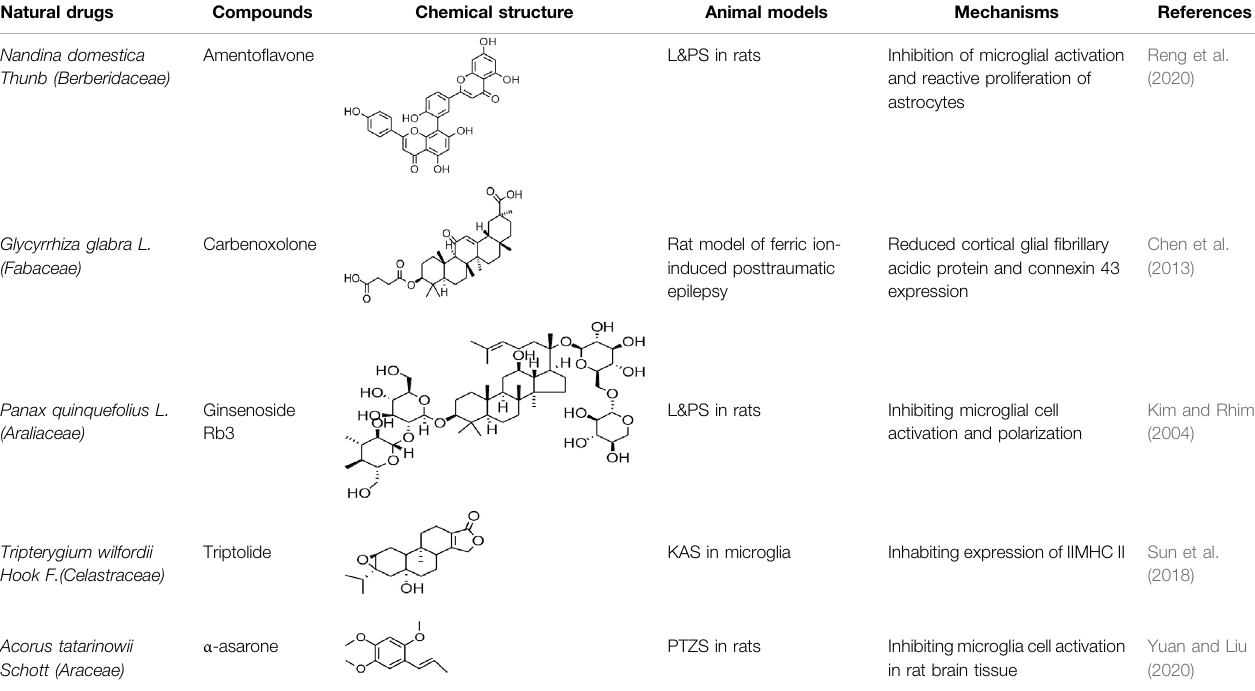
TABLE 5 | Natural drugs used to treat epilepsy by regulating glial